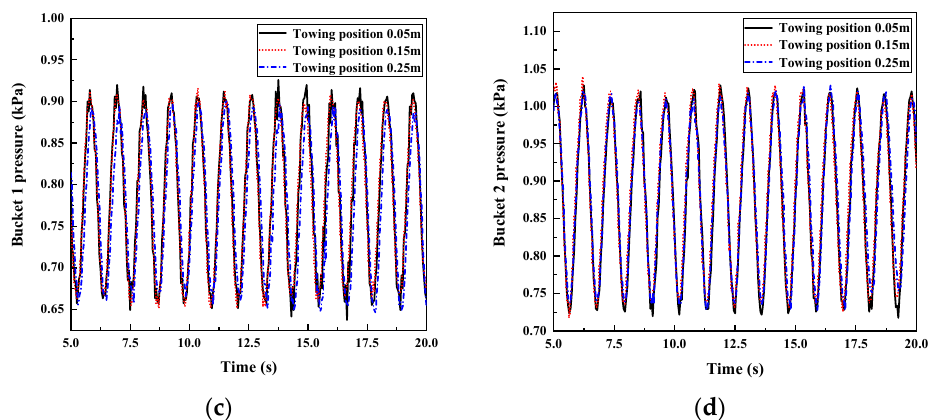
Figure 17. Dynamic response of the TBJF for different towing positions. ( a ) Towing force. ( b ) Pitch. ( c ) Bucket 1 pressure. ( d ) Bucket 2 pressure.